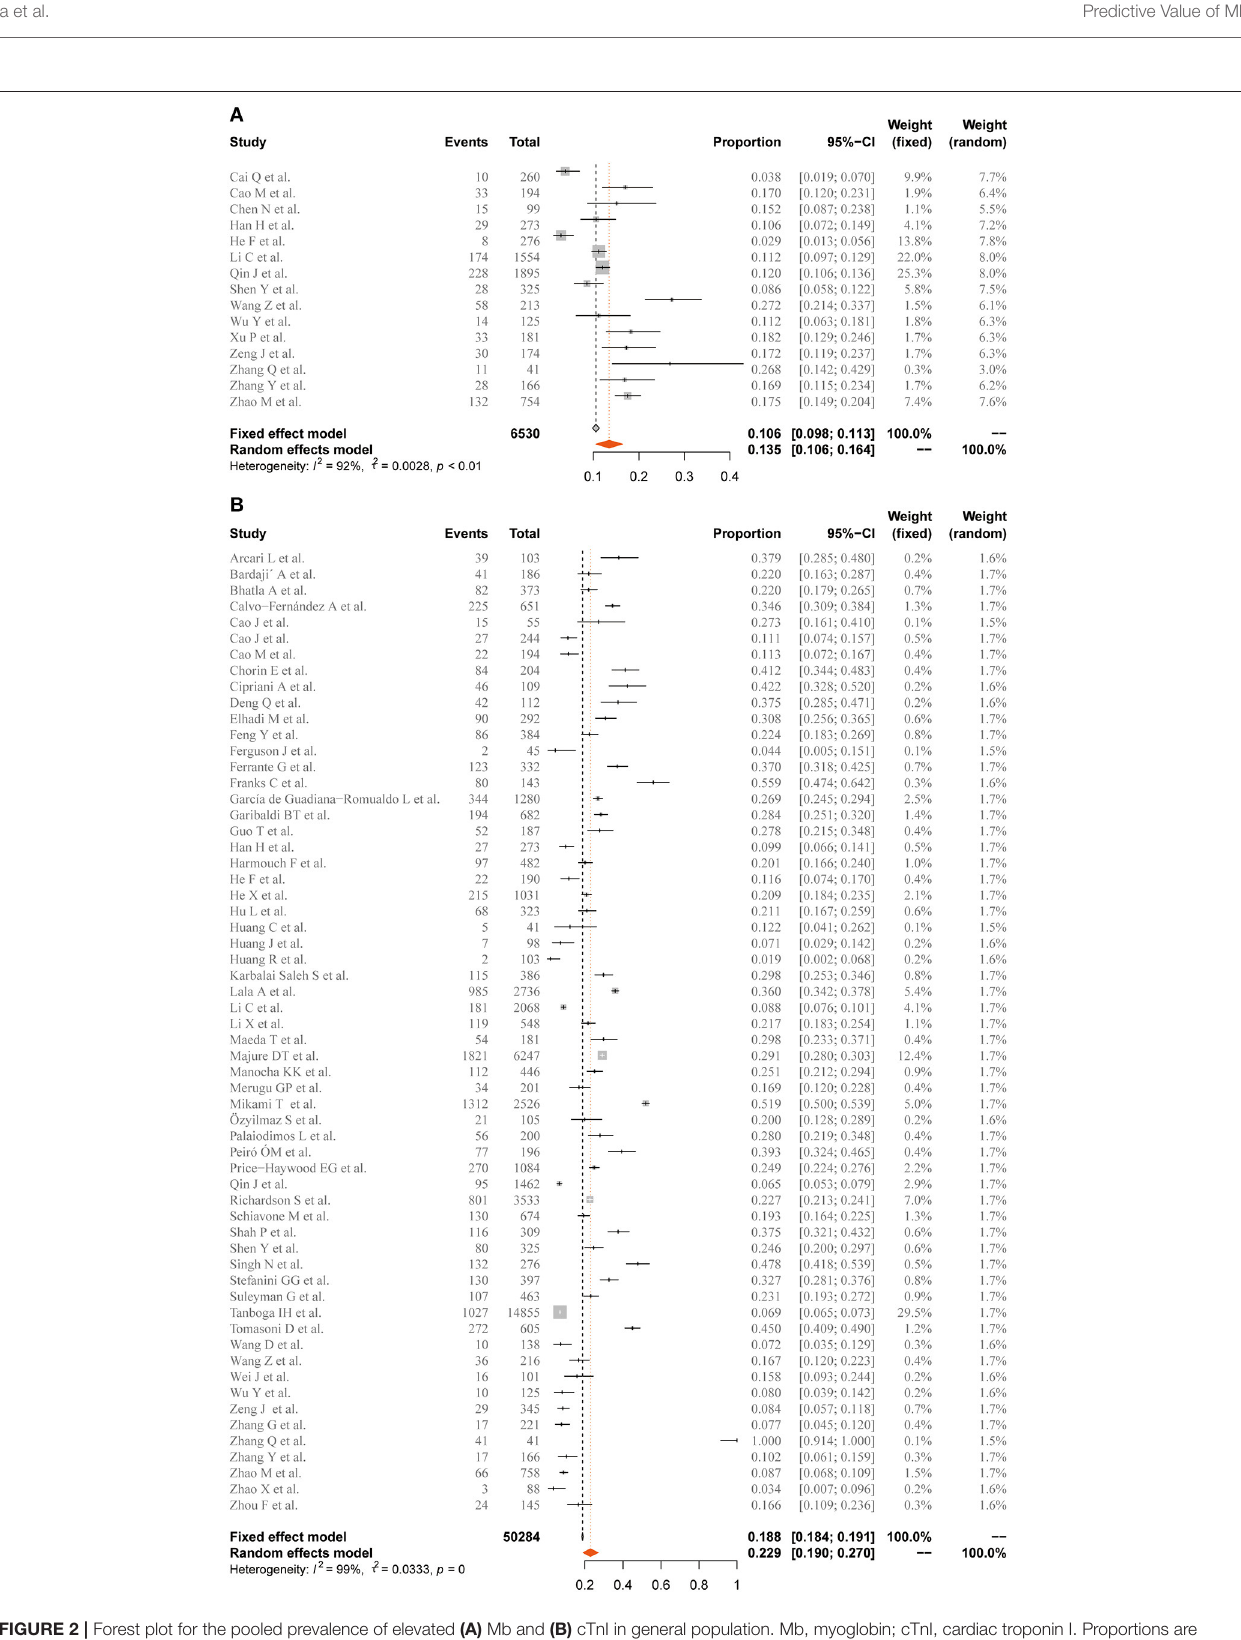
Frontiers in Cardiovascular Medicine |